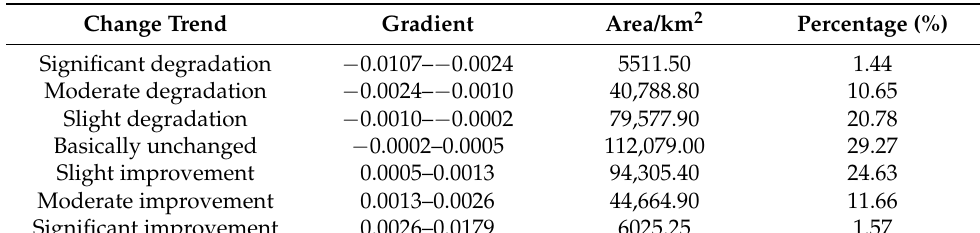
Figure 5. Distribution of the NDVI change trend during 1982–2015.